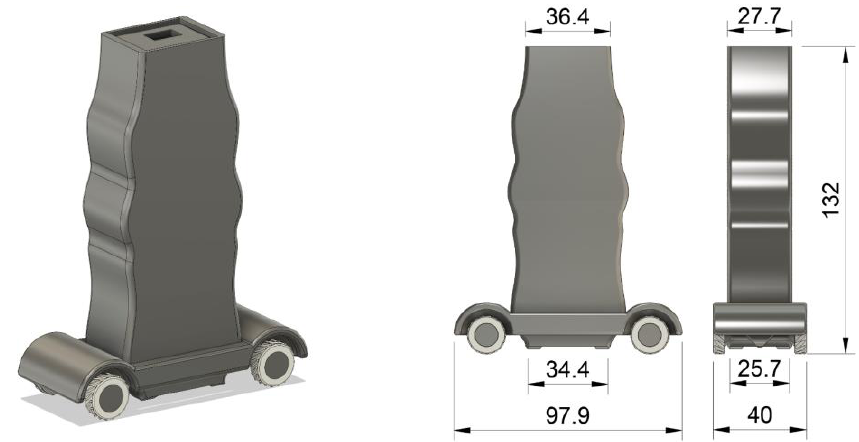
Figure 13. Three-dimensionally printed enclosure of the device (dimensions in mm).